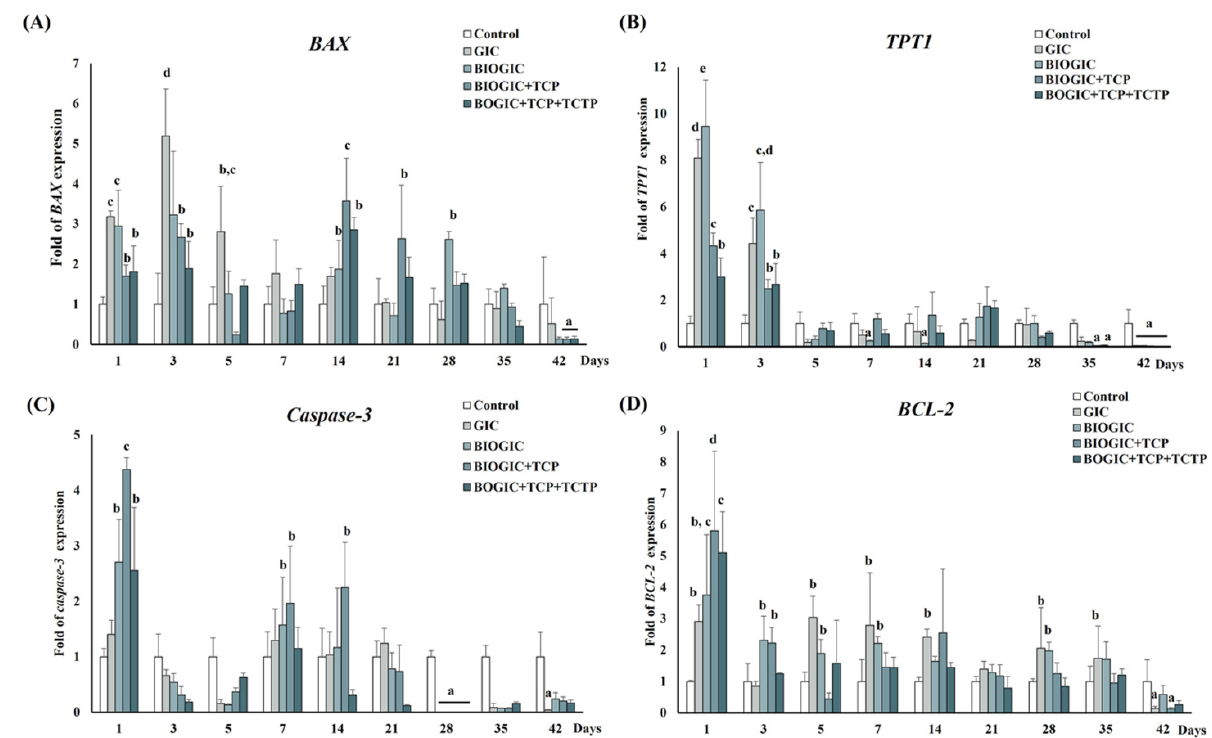
Figure 11. The quantification of mRNA gene expression related to cell apoptosis in hDPSCs cultured on each type of GIC for 1, 3, 5, 7, 14, 21, 28, 35, and 42 days was determined by qRT-PCR. ( A ) BCL2- associated X (BAX), ( B ) tumor protein translationally controlled 1 (TPT1), ( C ) (Caspase-3), and ( D ) B-cell lymphoma 2 (BCL-2). Data are represented as mean ± standard deviation (SD) of cell populations. Different lowercase letters represent significant difference between different groups within each time period at p < 0.05, one-way ANOVA with Tukey multiple comparison test ( n = 4 in each group).